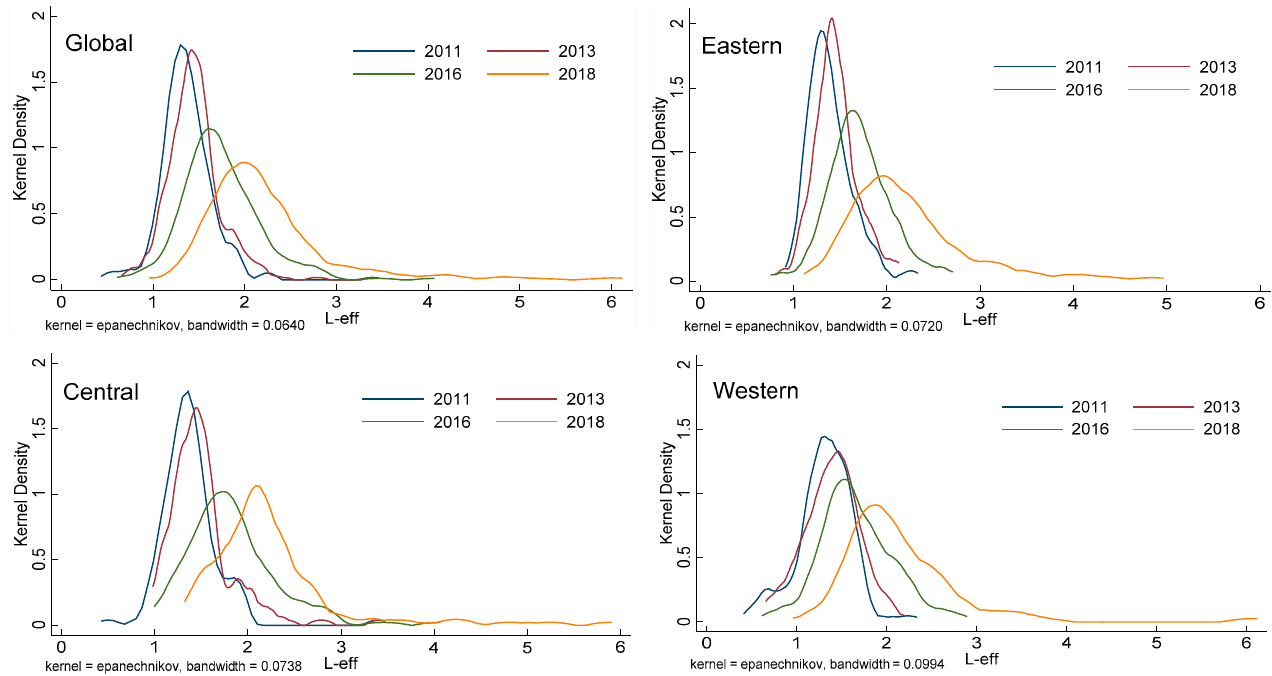
Figure 4. Temporal dynamic evolution characteristics of the green land utilization efficiency in China.